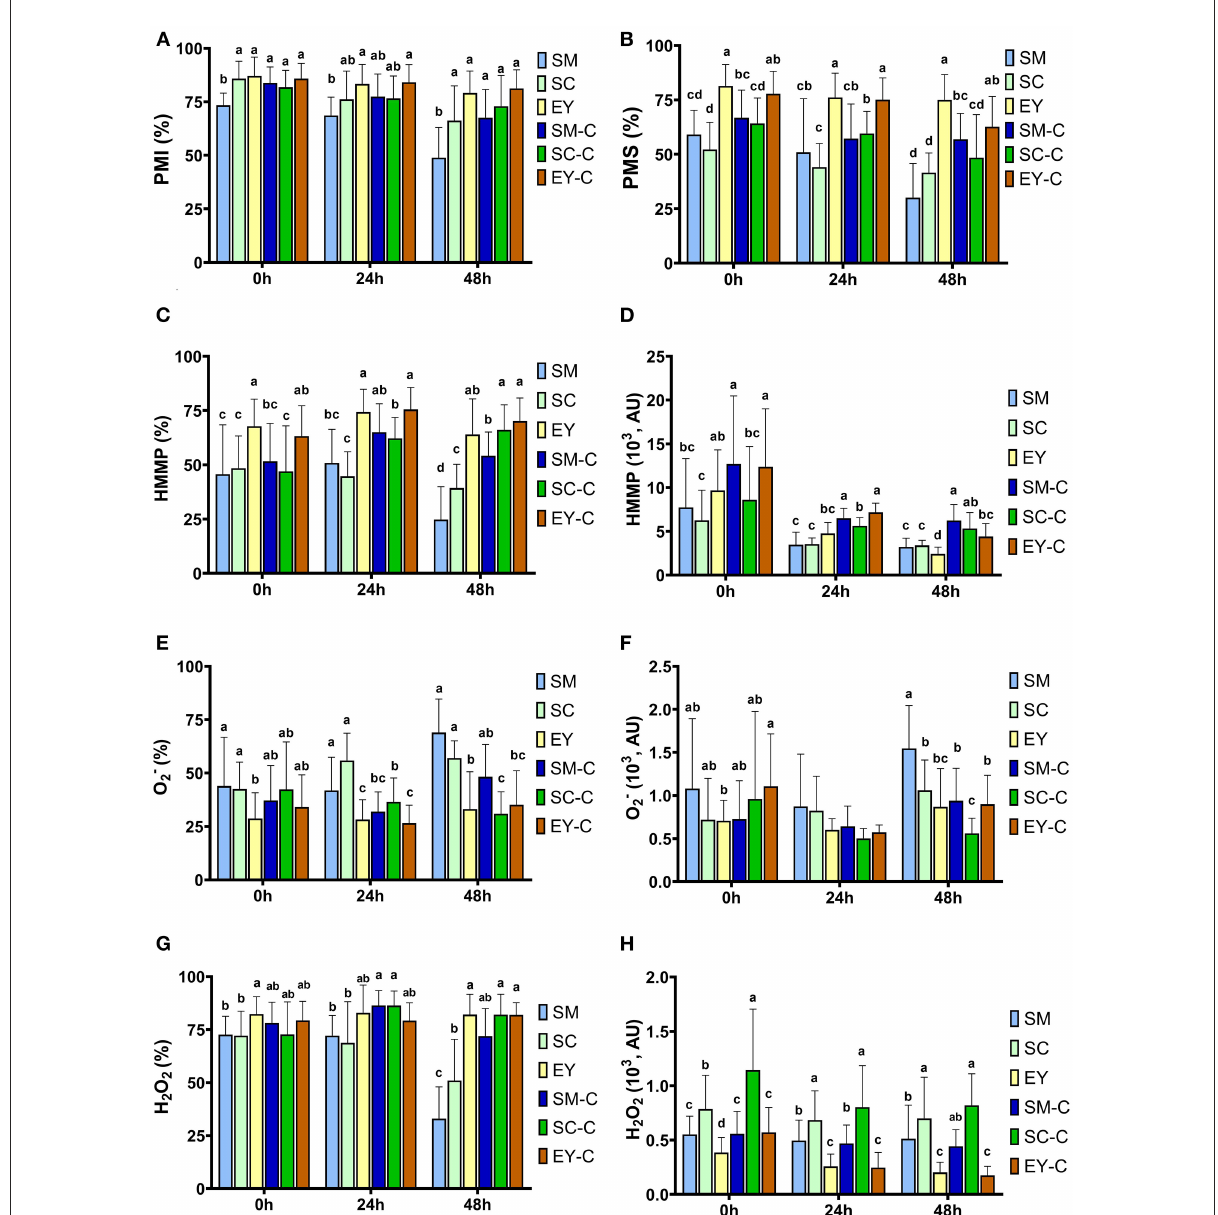
FIGURE2 Flow cytometry analyses of donkey semen centrifuged (C) or not and extended in skimmed milk (SM), sodium caseinate (SC) or egg yolk (EY)-based extender and cooled for 48h. (A) Percentage of sperm with intact plasma membrane (PMI); (B) Plasma membrane stability (PMS); (C) High membrane mitochondrial potential (HMMP); (D) Fluorescence intensity of light emitted from MitoStatusRed-stained sperm; (E) Sperm with high intracellular superoxide (O − 2 ); (F) Fluorescence intensity of light emitted from Dihydroethidium-stained sperm; (G) Sperm with high hydrogen peroxide (H 2 O 2 ); (H) Fluorescence intensity of light emitted from Dihydrorhodamine-stained sperm. AU, arbitrary unit. Different superscripts ( a,b,c,d ) denote differences between extenders ( P <